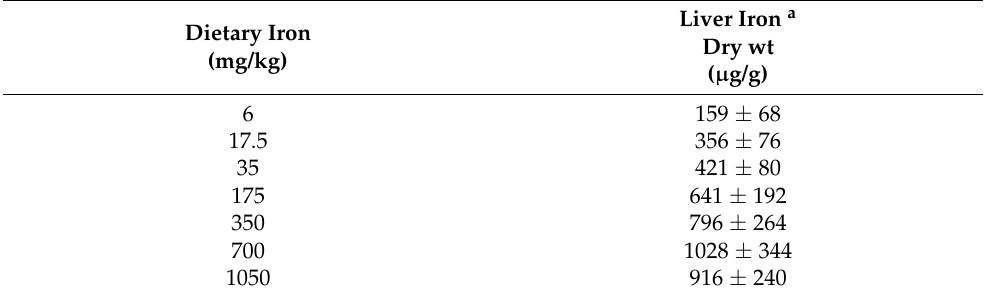
Table 4. Effect of dietary iron on body iron stores measured as hepatic iron concentration.